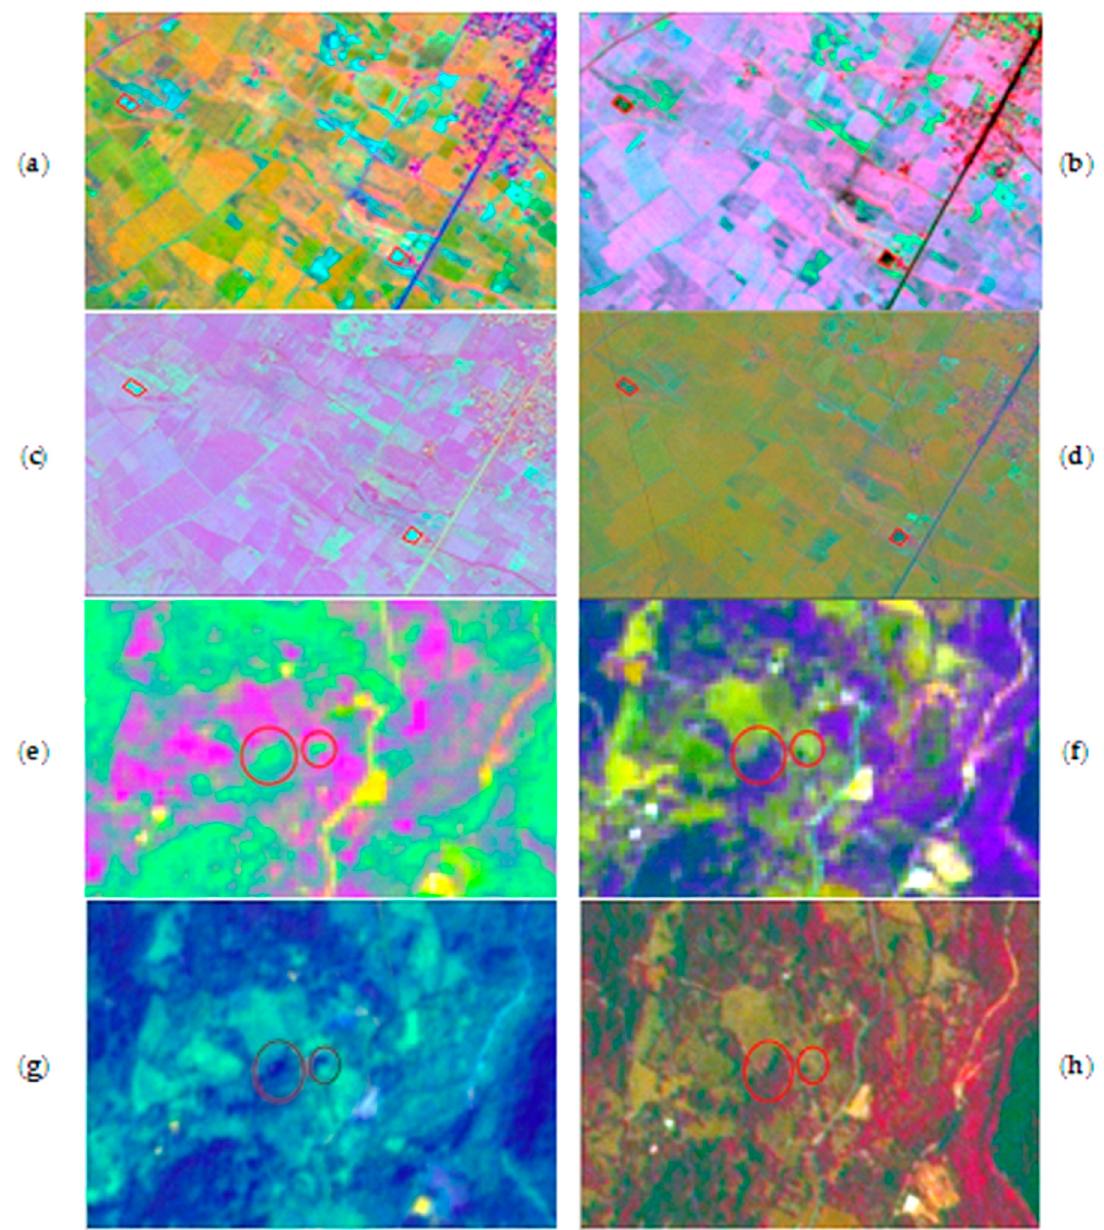
Figure 4. Results of the application of PCA method to the image shown in Figure 3 (Sentinel-2 and PlanetScope, Tunisian and Greek study areas). ( a ): Sentinel-2 PCA composite (RGB-248 band 2, band 4, band8) in 25/February/2020, Tunisian study areas, ( b ): Sentinel-2 PCA composite (band 2, band 4, band8) in 26/August/2020, Tunisian study areas, ( c ): PlanetScope PCA composite (band 2, band 3, band4) in 25/February/2020, Tunisian study areas, ( d ): PlanetScope PCA composite (band 2, band 3, band4) in 25/August/2020, Tunisian study areas, ( e ): Sentinel-2 PCA composite (band 2, band 4, band8) in 25/February/2020, Greek study areas, ( f ): Sentinel-2 PCA composite (band 2, band 4, band8) in 18/August/2020, Greek study areas, ( g ): PlanetScope PCA composite (band 2, band 3, band4) in 25/February/2020, Greek study areas, ( h ): PlanetScope PCA composite (band 2, band 3, band4) in 18/August/2020, Greek study areas.